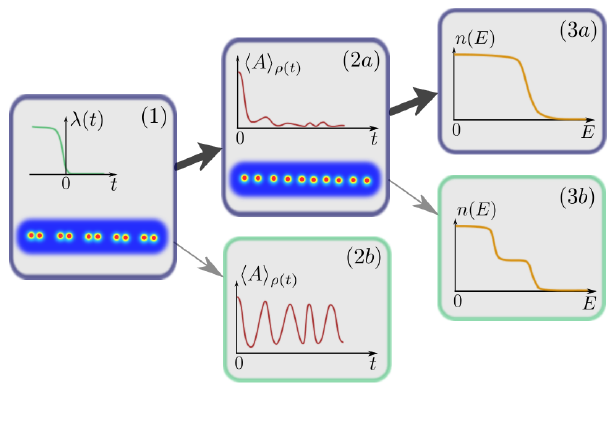
Figure 1: Thermalization and equilibration are often studied in a dynamical quench scenario, where a parameter in the Hamiltonian is suddenly quenched to zero, which knocks the system out of equilibrium (1). The subsequent process of (generalized) thermalization has two components. First, the system must relax to a steady state (2a) with respect to meaningful quantities. Exceptions to this are typically charac- terized by oscillations, as in (2b). Second, if equilibration occurs, the equilibrium state must be thermal (exemplified here by the Fermi-Dirac distribution in (3a)), or correspond to a generalized Gibbs ensemble (3b) in case further constants of motion are